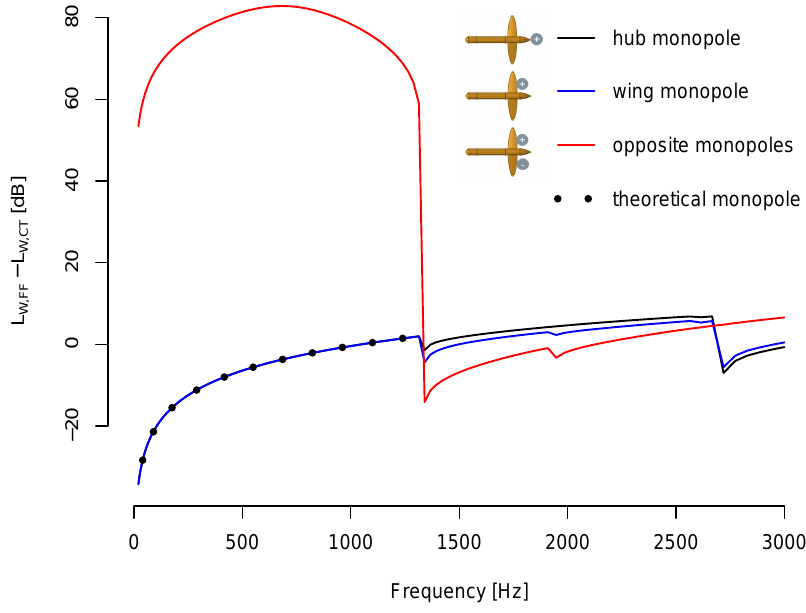
Figure 16. Correction terms for sound power levels for monopole(s) near the